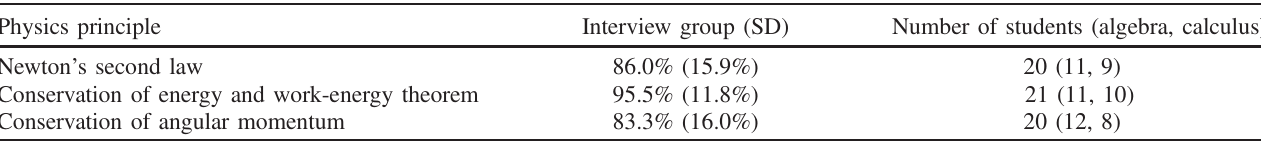
TABLE I. The average paired problem scores and standard deviations (SD) for students in the one-on-one implementation group. Physics principle